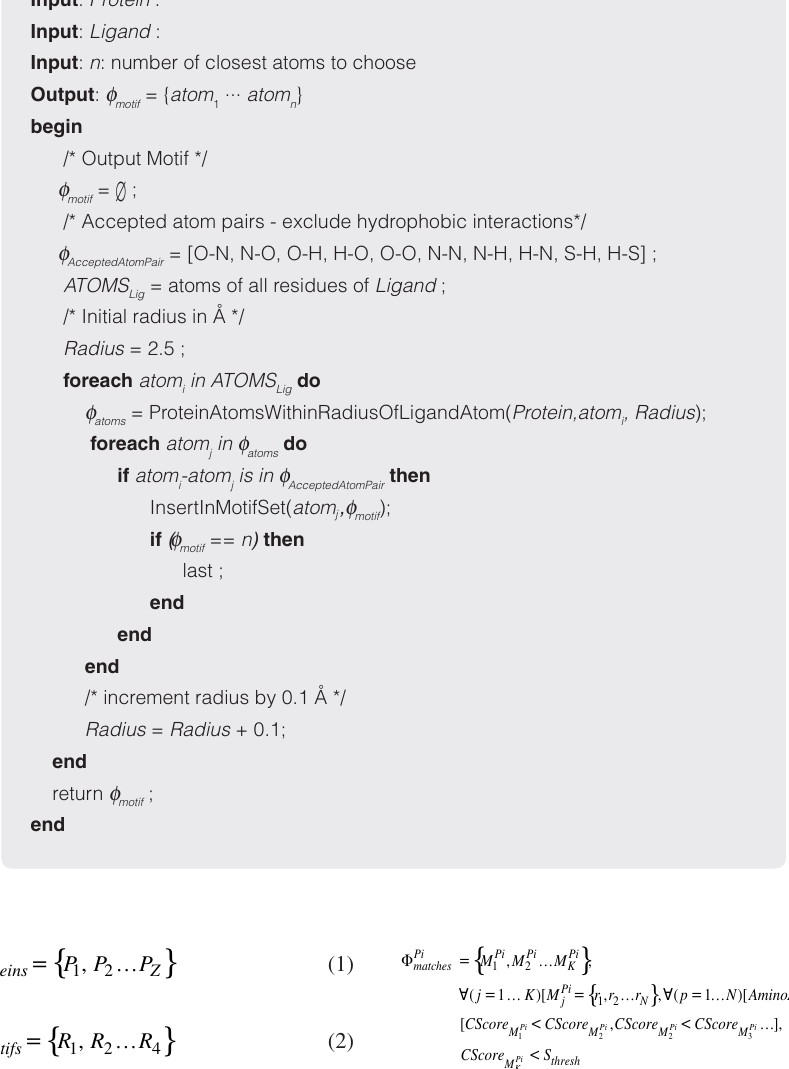
Algorithm 1. GetMotif(): Choose n closest atoms, excluding hydrophobic